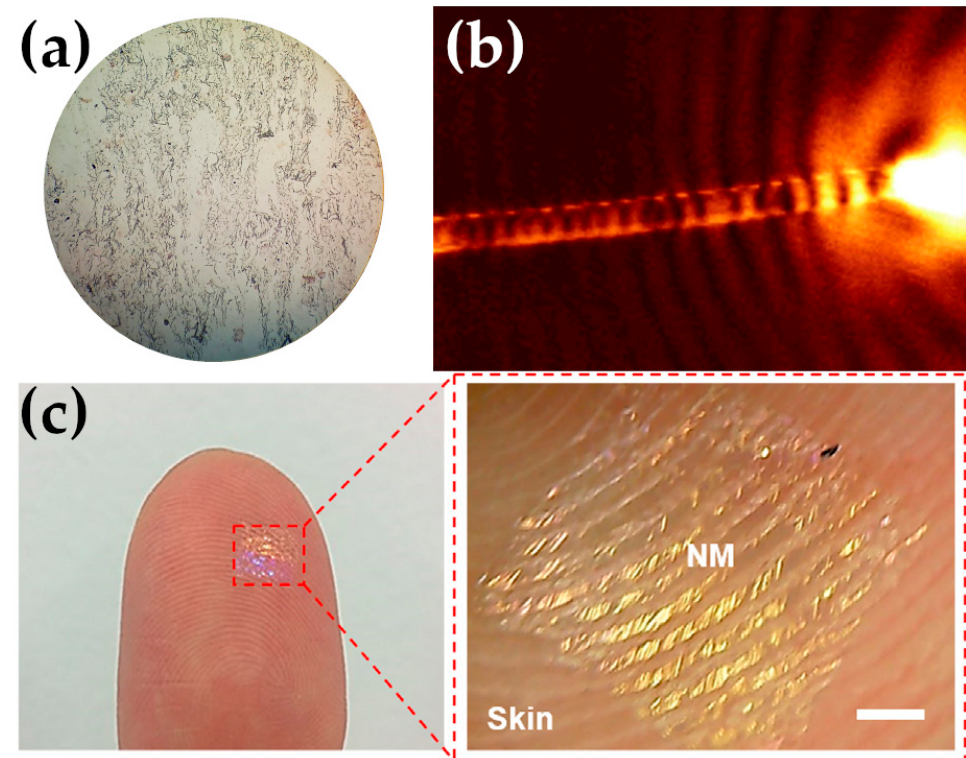
Figure 6. ( a ) Optical image of an ITO substrate covered with a Ag NWs transparent film. ( b ) Scanning near-field optical microscopy (SNOM) image of the propagation of a surface plasmon along an 18:6 µm long Ag NW. Reprinted figure with permission from Ref. [145]. Copyright (2005) by the American Physical Society. http://dx.doi.org/10.1103/PhysRevLett.95.257403 (accessed on 1 December 2022). ( c ) Hybrid PDMS/AgNWs conductive nanomembrane attached to a thumb. Scale bar is 1 mm. Reproduced from Ref. [146] with no modification under Creative Commons 4.0 license (https://creativecommons.org/licenses/by/4.0/, accessed on 1 December 2022).